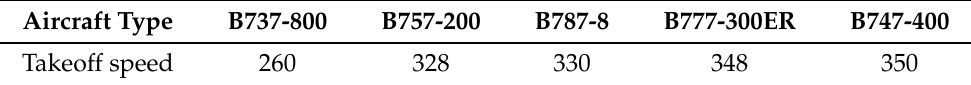
Figure 6. Aircraft taxiing speed and mainwheel load for each ADAMS/Aircraft prototype model. Table 4. Takeoff Speed for Five Types of Aircraft (km/h).